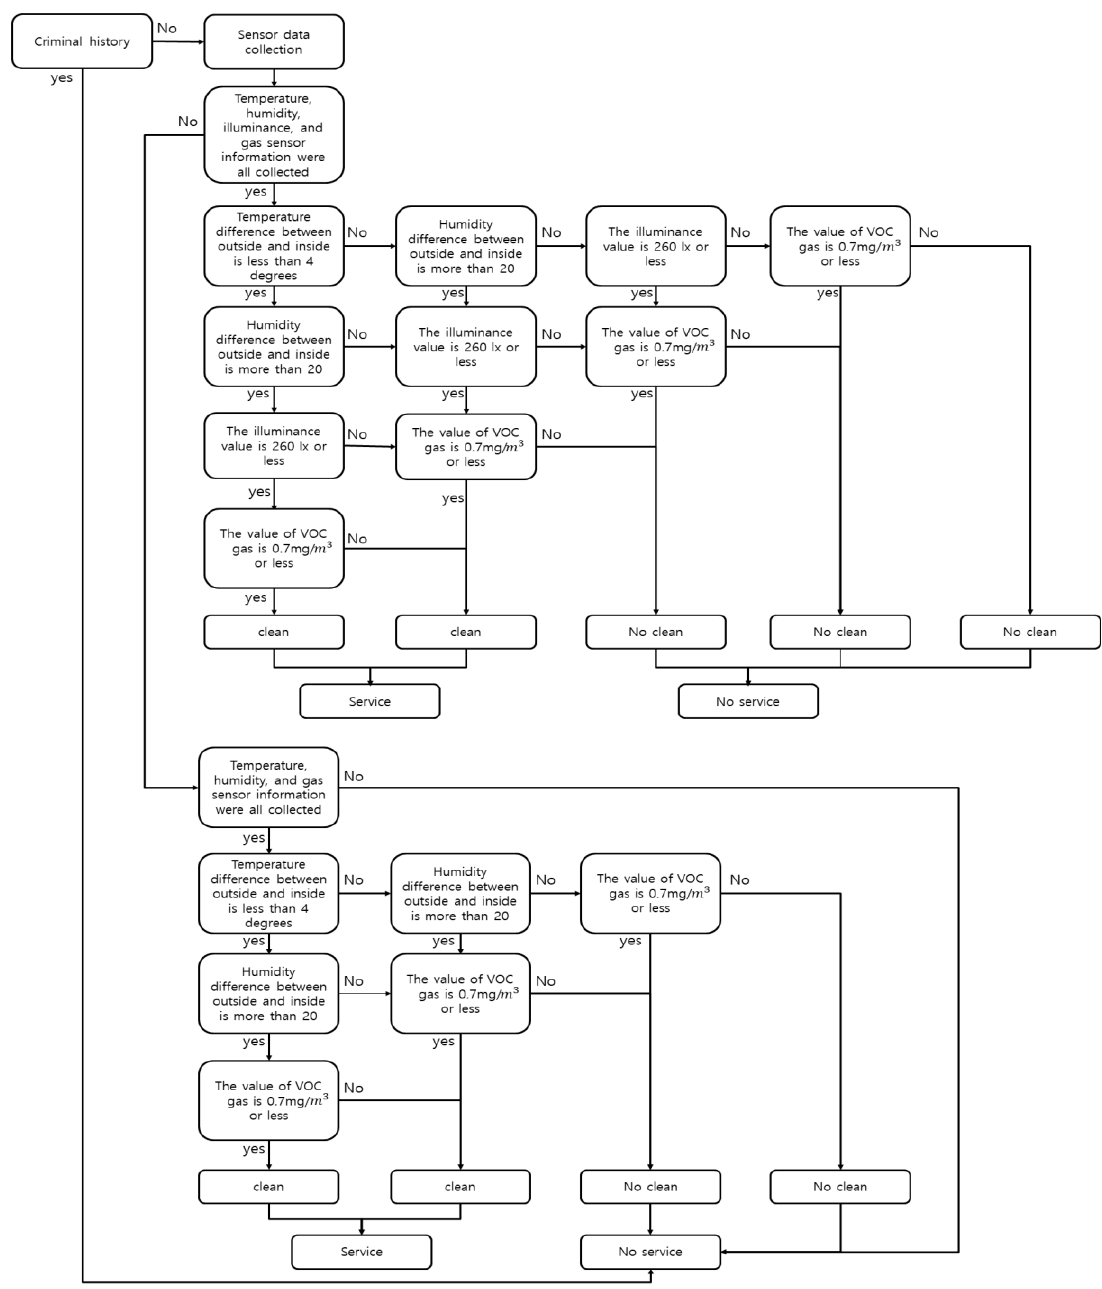
Figure 12. Flow diagram for processing sensor data.